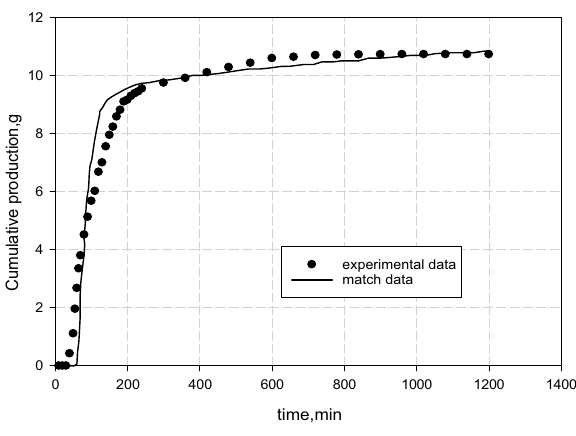
2 -flooding experi- Fig. 6 Capillary pressure curve for different schemes (experiment 1) Table 3 Capillary pressure function parameters in the CO